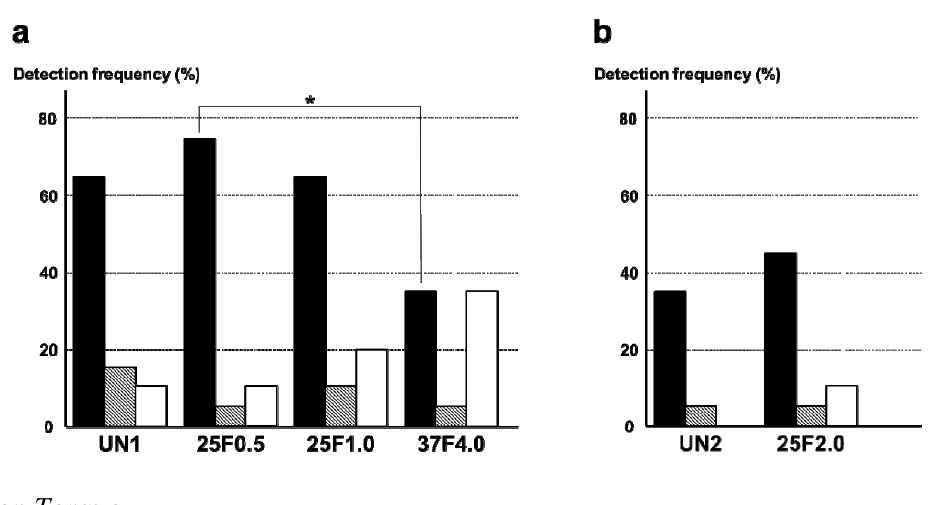
Figure 13. Detection frequencies of S. aureus and E. coli around the pin tracts of ( a ) the UN1, 25F0.5, 25F1.0, and 37F4.0 groups; ( b ) the UN2 and 25F2.0 groups.